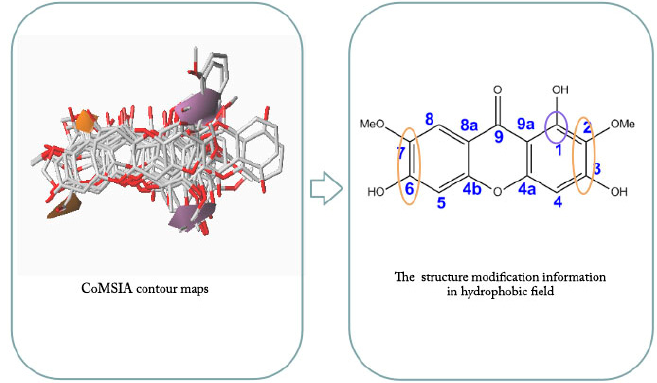
Figure 8. Hydrophobic field views of 14 xanthones.